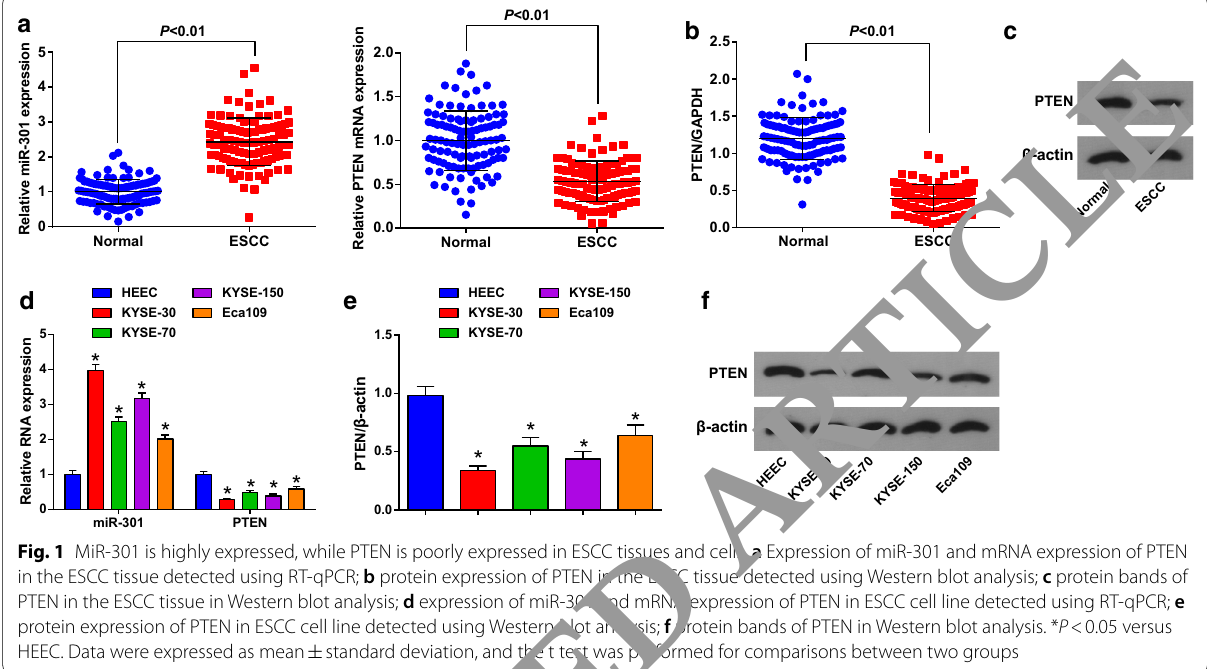
Table 2 Relation between clinicopathological features and expression of miR-301 and PTEN in ESCC patients Clinicopathological